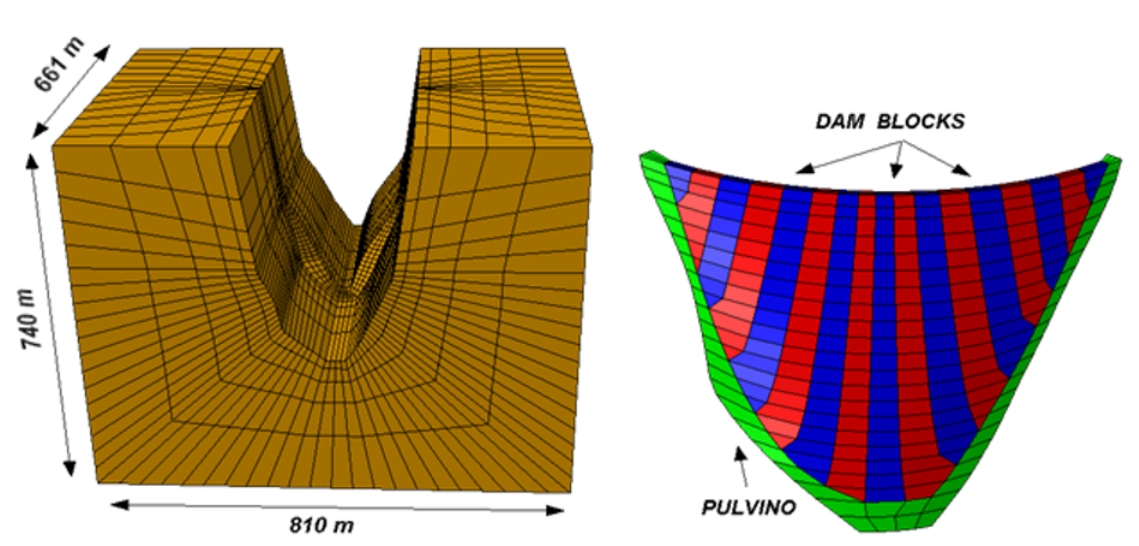
Figure 5. Finite element model of dam body and foundation